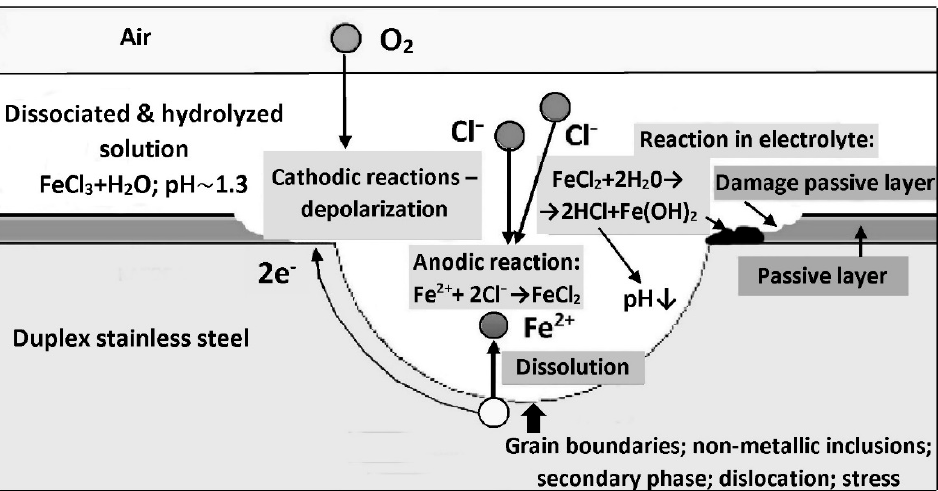
Figure 11. Pitting corrosion mechanism of duplex steel when exposed to chloride attack (according to [21]).